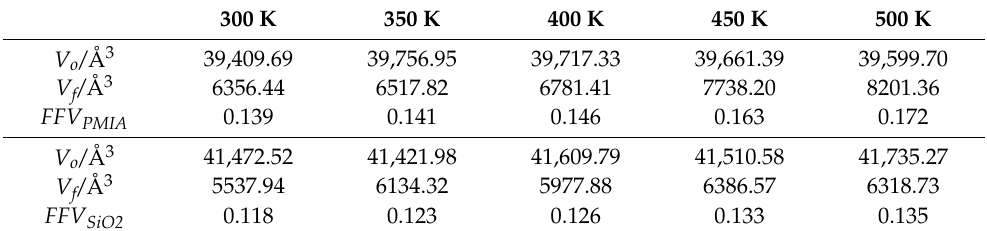
Table 2. Free volume ratio of the PMIA and SiO 2 /PMIA models at different temperatures.